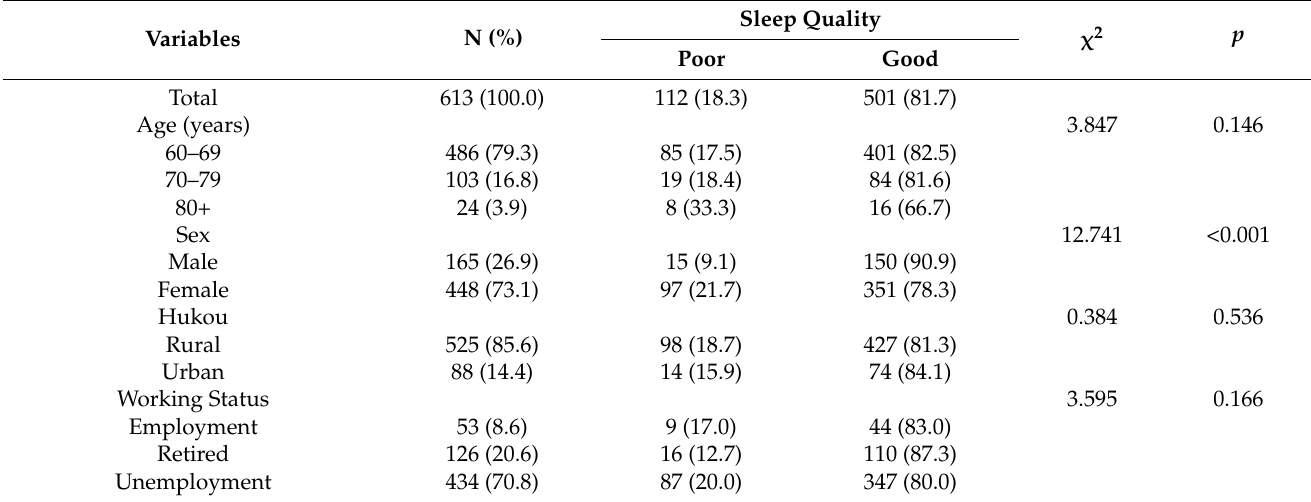
Table 1. The sociodemographic characteristics of the